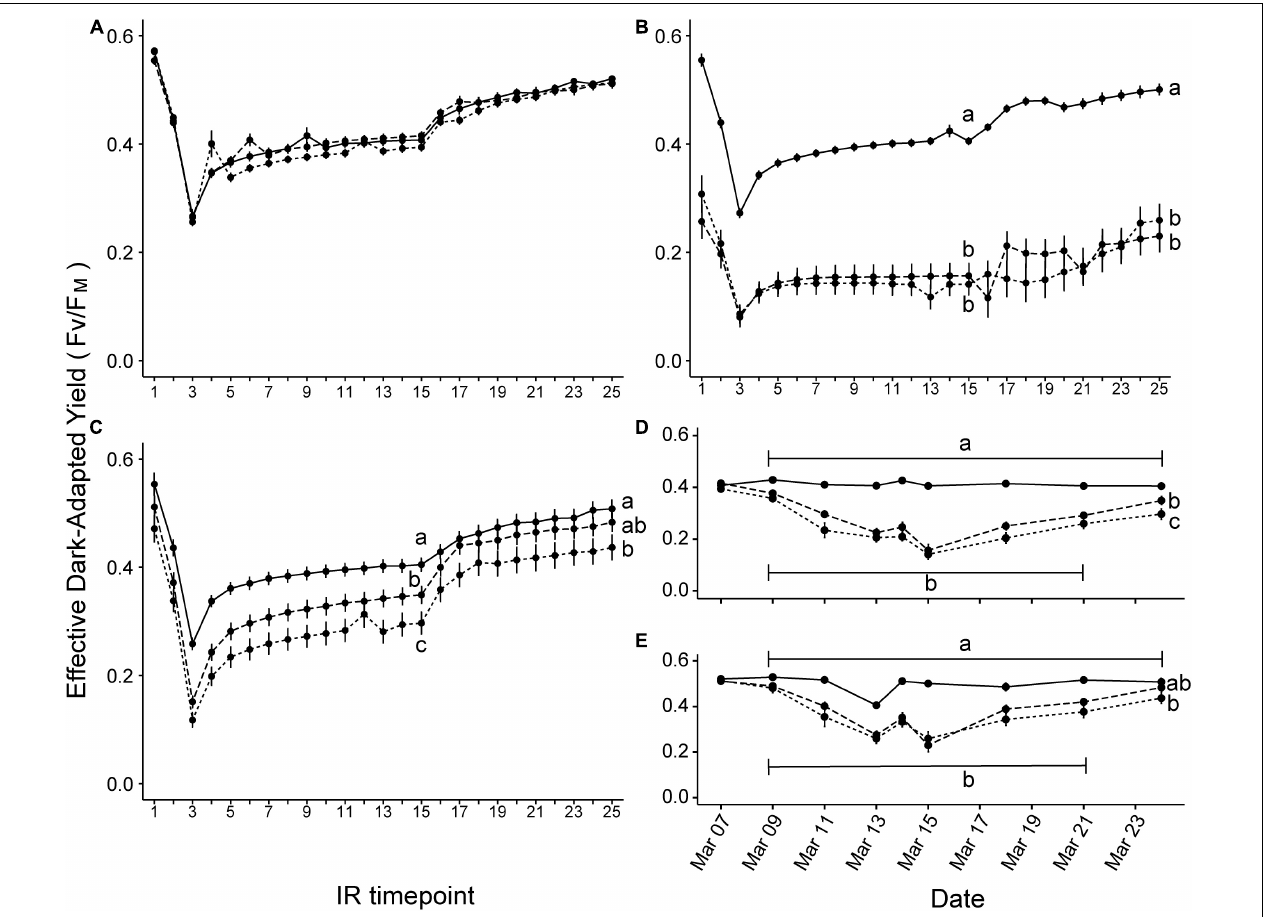
FIGURE 3 | Symbiodiniaceae induction + recovery curves for effective dark-adapted yield of photosystem II in ambient (solid line), short stress (short dashes), and long stress (long dashes) scenarios. Plots show the effective dark-adapted yield for measurements taken nearest to each sampling timepoint during the final heating period, e.g., (A) Day 22, (B) Day 34, and (C) Day 43. Different lowercase letters indicate significant differences between treatments at the end of the induction recovery period (IR timepoint 15) and the dark recovery period (IR timepoint 25) (Tukey post hoc test, p < 0.05). Plots (D,E) show the change in effective quantum yield values of IR timepoint 15 and 25, respectively, across treatments over the entire warming period, indicating a trend of negative response to heat stress followed by gradual